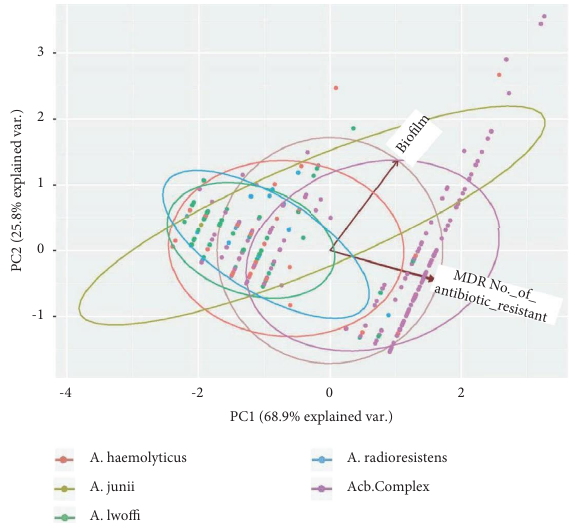
Figure 3: Principle component analysis (PCA) among Acineto- bacter species, Bioflm formation, MDR, and a number of antibiotic